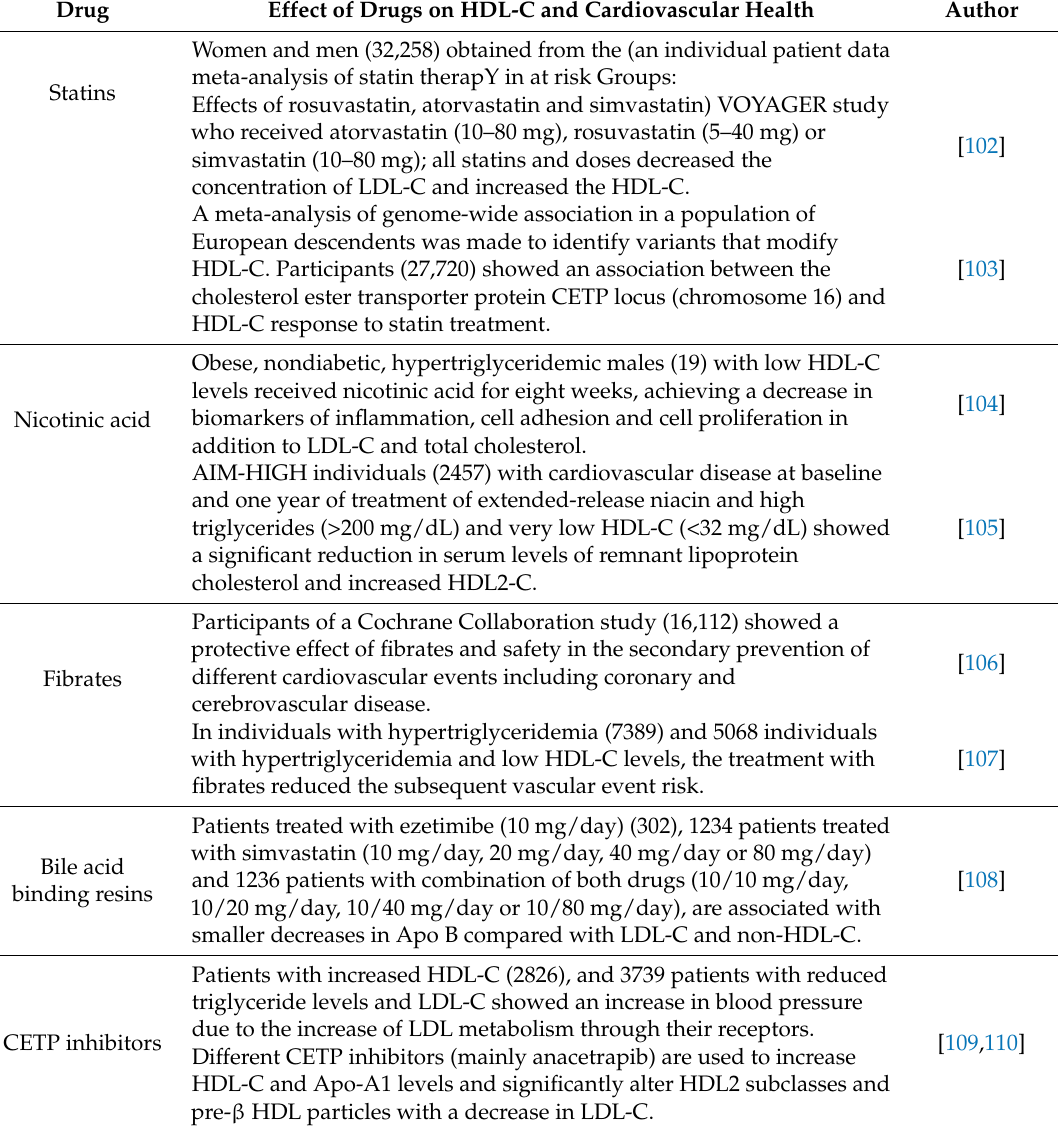
Table 1. Pharmacological treatments for decreasing the risk of cardiovascular